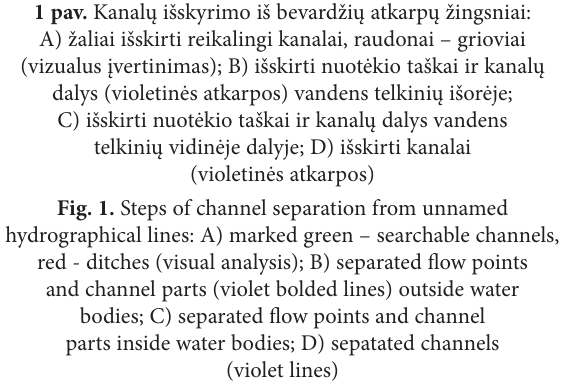
Fig. 1. Steps of channel separation from unnamed hydrographical lines: A) marked green – searchable channels, red - ditches (visual analysis); B) separated flow points and channel parts (violet bolded lines) outside water bodies; C) separated flow points and channel parts inside water bodies; D) sepatated channels (violet